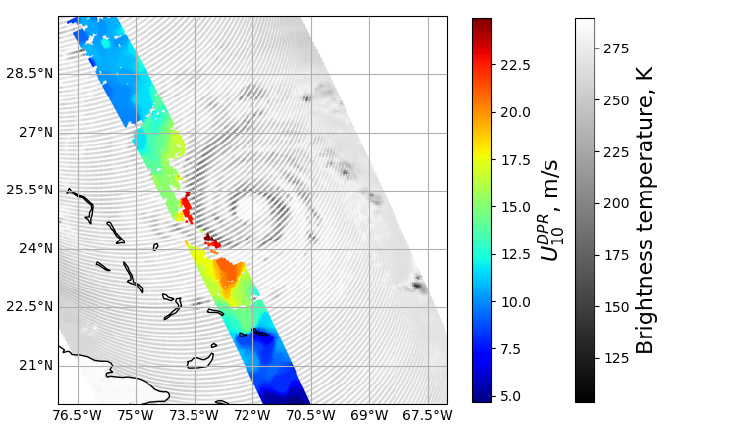
Figure 7. Wind speed over the image of brightness temperature from the GMI data at 89 GHz, V-polarization, Hurricane Maria at 12:15 UTC on 23 September 2017. Hurricane Dorian was observed with the Ku-band DPR instrument on 30 August 2019.